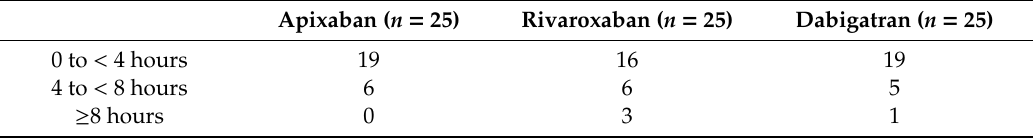
Table 2. Time from last DOAC dose to blood sampling in each DOAC